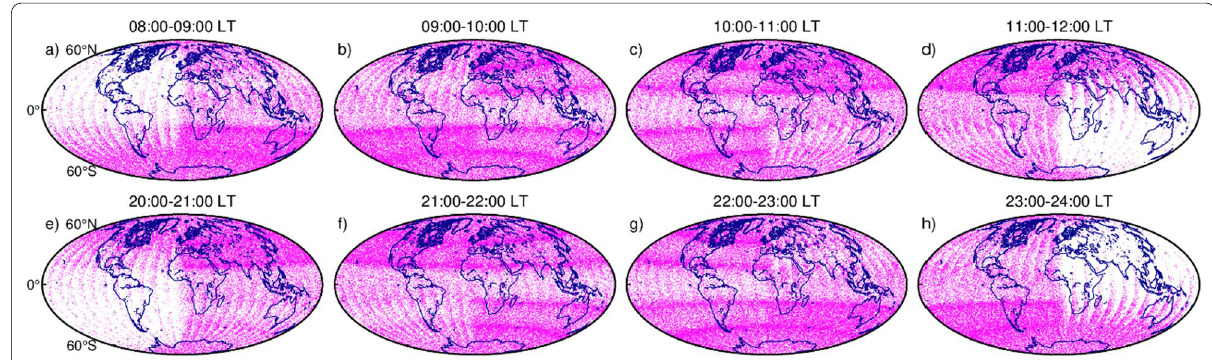
Fig. 8 Spatial distributions of FY-3C GPS RO events for different 1-h local time intervals during Jan. 2015 to Dec. 2019. Plots for local time intervals a 8:00–9:00 LT, b 9:00–10:00 LT, c 10:00–11:00 LT, d 11:00–12:00 LT, e 20:00–21:00 LT, f 21:00–22:00 LT, g 22:00–23:00 LT, and h 23:00–24:00 LT